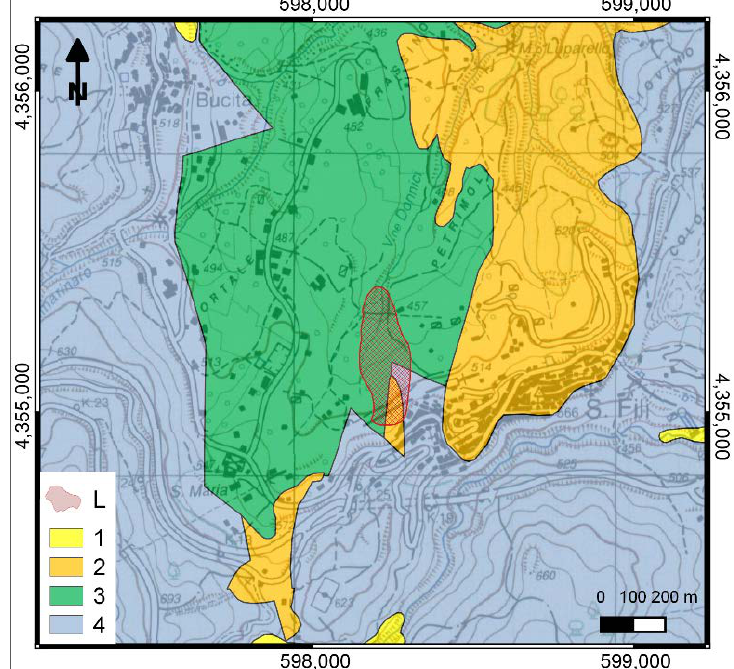
Figure 5. Lithological sketch of the Uncino landslide at San Fili. Key: (1) Alluvium, colluvium, and residual soil; (2) conglomerate and sandstone; (3) Clay and clayey flysch; (4) Igneous and medium-high grade metamorphic rock. The landslide (L) is marked by a red hatched polygon. Topographic base map after 1:25,000 IGMI sheets; lithological map after [47], Geological map of Calabria (scale 1:25,000), mod.